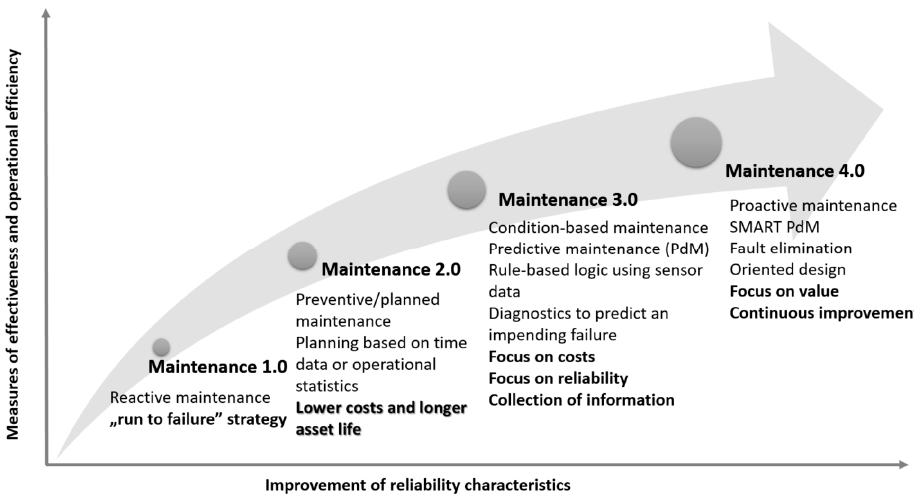
Figure 5. Main approaches to maintenance. Source: own contribution based on [1].